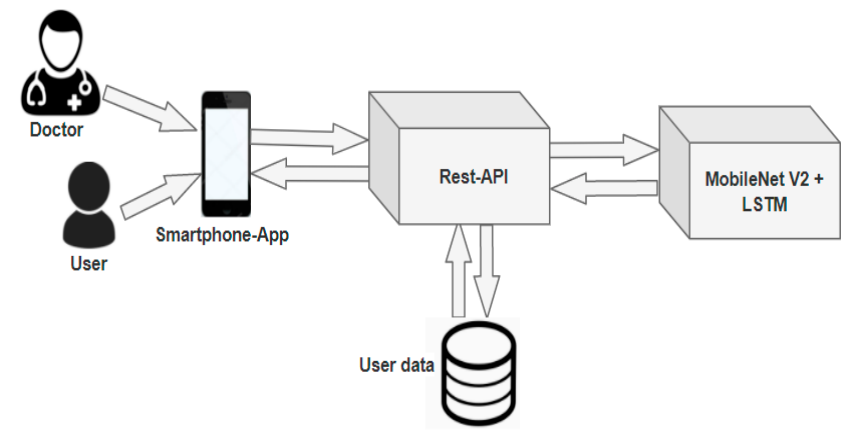
Figure 14. The framework of the proposed mobile application modules doctor, user, Rest-API for database connectivity, and the database.